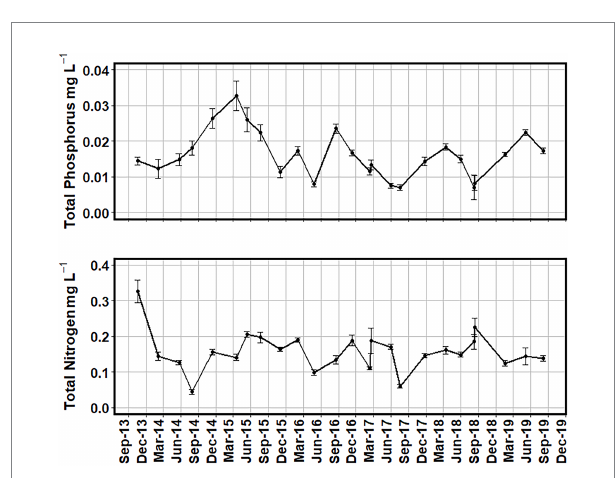
FIGURE 7 Mean surface total nitrogen and total phosphorus concentration (mg L − 1 ) for all sites from October 2013 to August 2019. Error bars of one standard error are added to show the variance of the values.